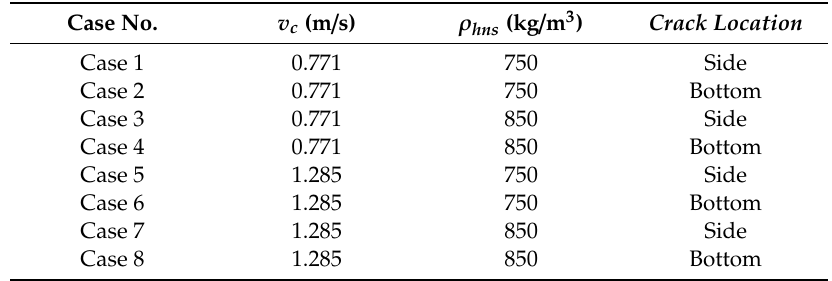
Table 3. Inlet variables of additional eight